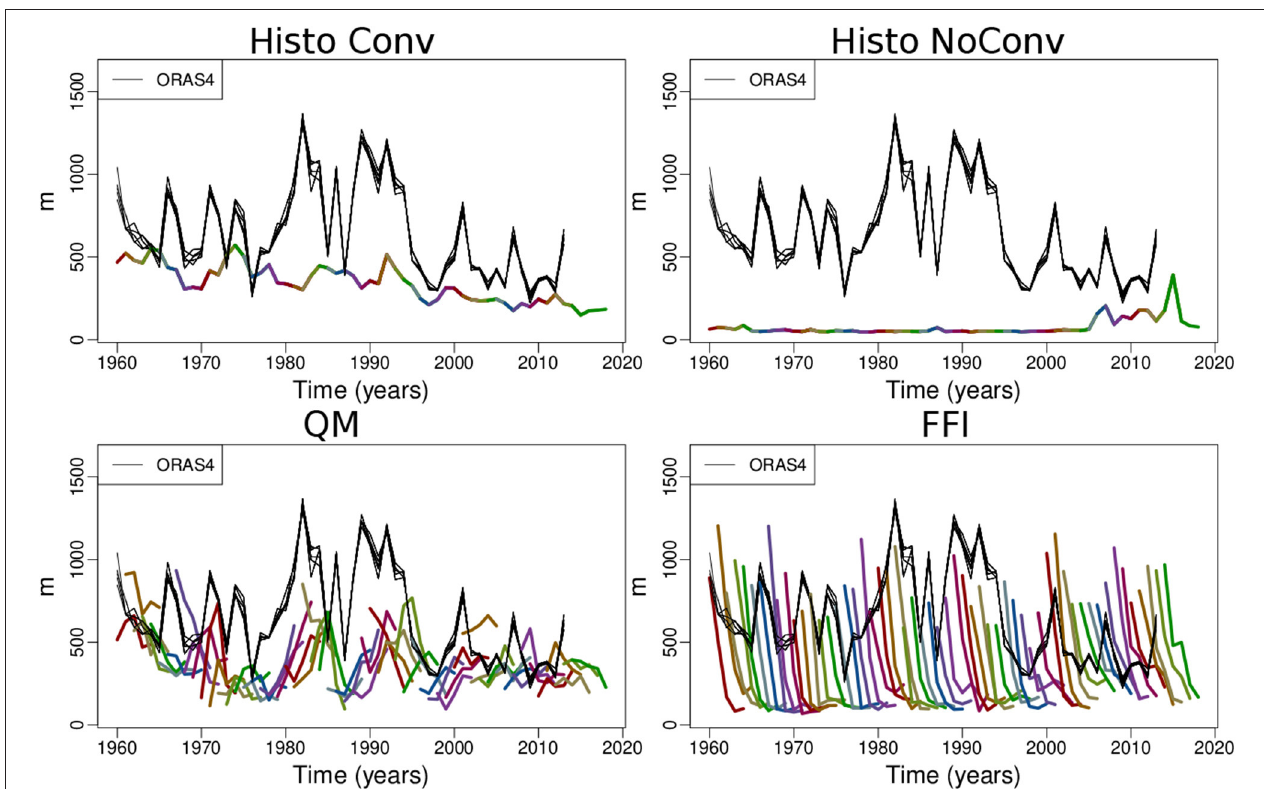
FIGURE 7 | Evolution of the mixed layer depth ensemble mean for the February–March–April average in the Labrador Sea. The top row shows the Histo ensemble splitted into members that exhibit a regular convection activity (left) , from the three which show no convection throughout most of the historical period (right) . The second row shows, respectively, the QM (left) and the FFI (right) evolution. The different start dates are represented with different colors. The NEMOVAR-ORAS4 is shown in black.